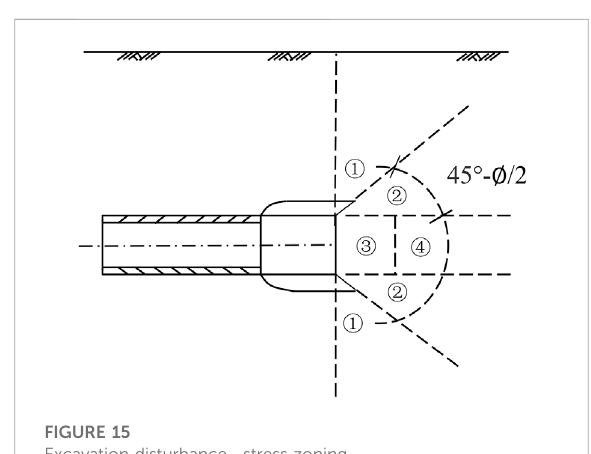
FIGURE 15 Excavation disturbance — stress